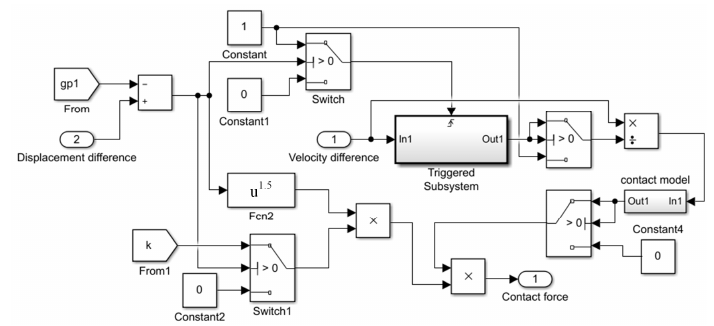
Figure 6. Contact force calculation sub ‐ module.